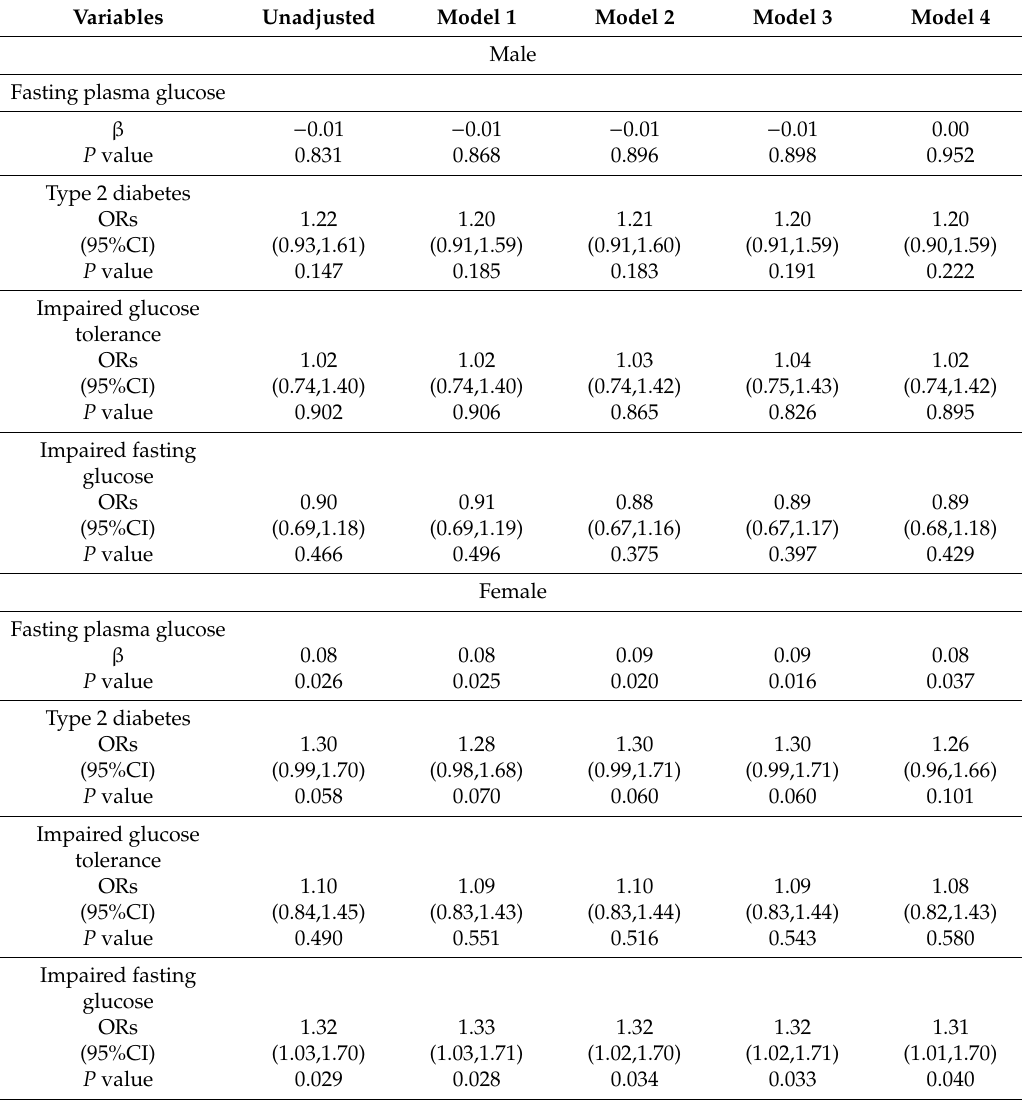
Table 4. Associations between fetal famine and the risk of dysglycemia in adulthood in di ff erent